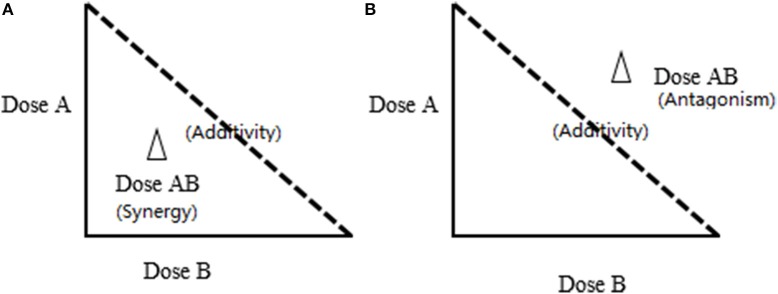
The lsobole method for synergy study. Dose A and Dose B are the individual concentrations of Components A and B; Dose AB are the concentrations of A and B in the combination. The dashed line shows zero interaction between A and B, which represents a simple additive effect. The effect of the combination equals the sum of the effects from individual components. (A) Effect of synergy: the dot is underneath the dashed line. (B) Effect of antagonism: The dot is above the dashed line; Addition: The dot is on the dashed line.